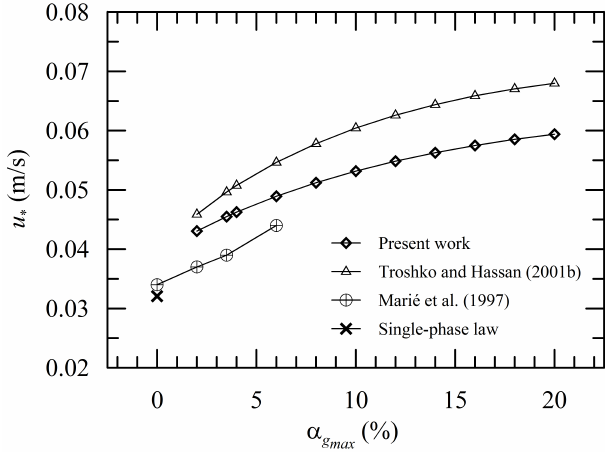
Figure 3 - Model sensitivity to α g